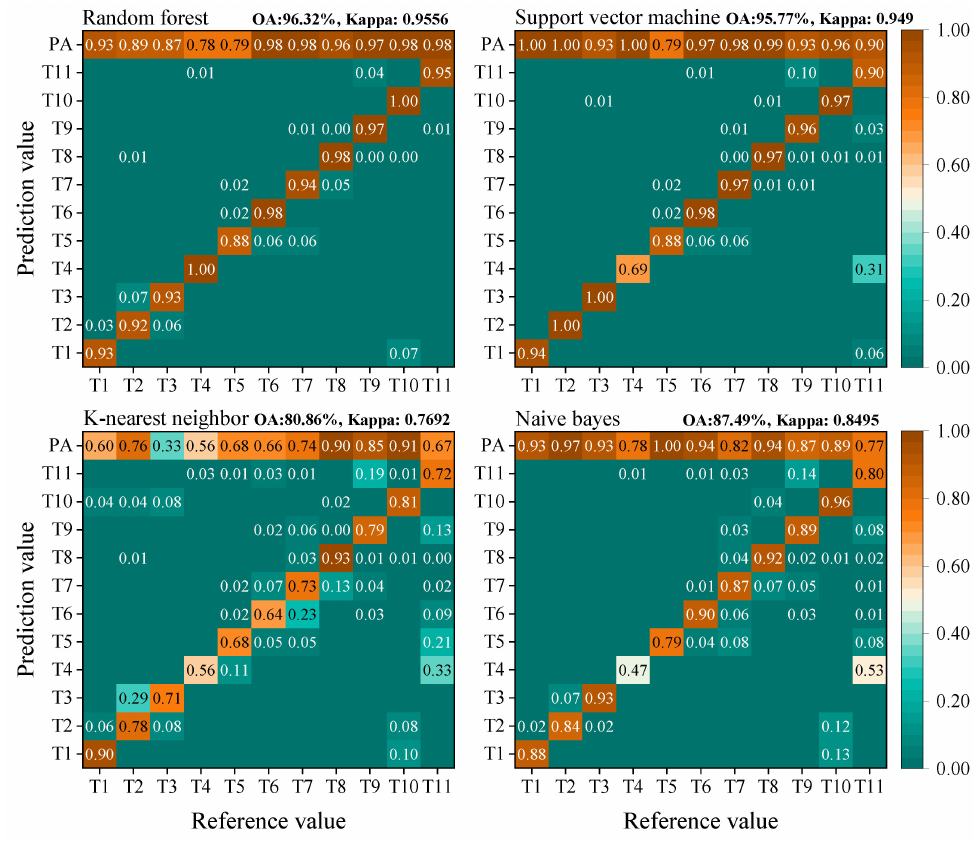
Figure 5. Confusion matrices for the optimized pixel-based classifications.